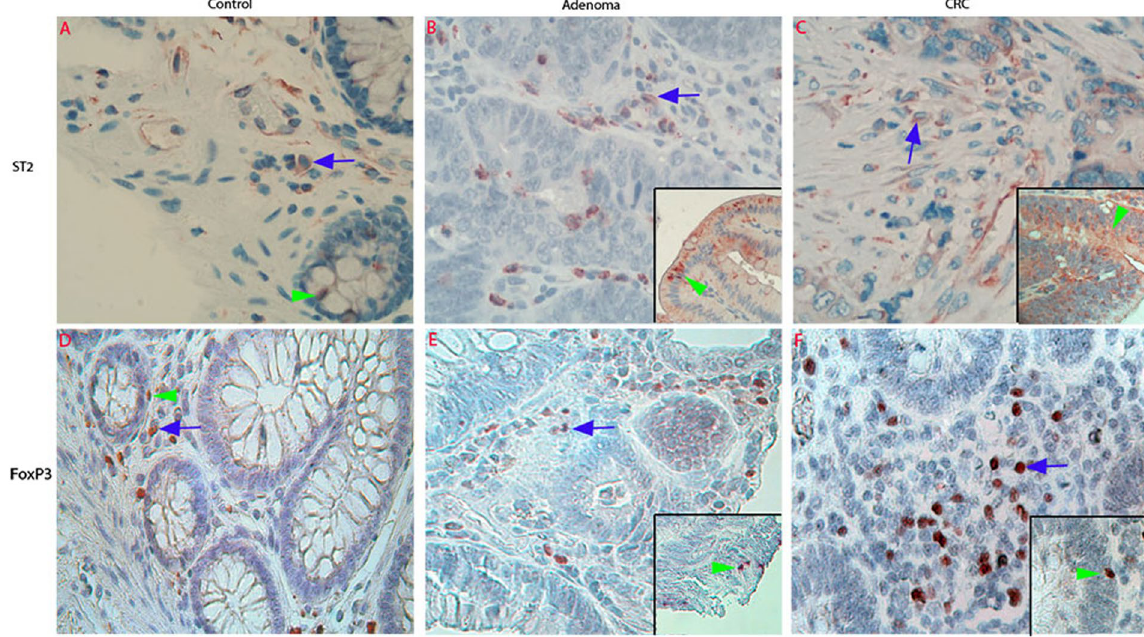
Figure 2. Photographic representations and density analysis of ST2-positive cells and Foxp3-positive Tregs in normal colorectal, adenoma and CRC tissues examined with immunohistochemistry (IHC). IHC images in first panel of Fig. 2 showed that ST2-immunoreactivity (IR) in the control tissues was observed in both the epithelium ( green arrowhead in A ) and lamina propria ( blue arrow in A ). In the adenoma and CRC tissues, increased ST2-IR was observed in both the adenoma ( green arrowhead in inserted image in B )/CRC epithelium ( arrowhead in inserted image in C ) and adenoma ( blue arrow in B )/CRC stroma ( blue arrow in C ). As seen in second panel of Fig. 2, low density of Foxp3-positive Tregs were observed in control lamina propria ( blue arrow in D ). However, dense Foxp3-positive Tregs were found in both the adenoma ( blue arrow in E )/CRC stroma, ( blue arrow in F ), and some were infiltrated into adenoma/CRC epithelium (green arrowhead in inserted images in E,F ). ( A–F : IHC, counterstained with hematoxylin, original magnification 200 ×